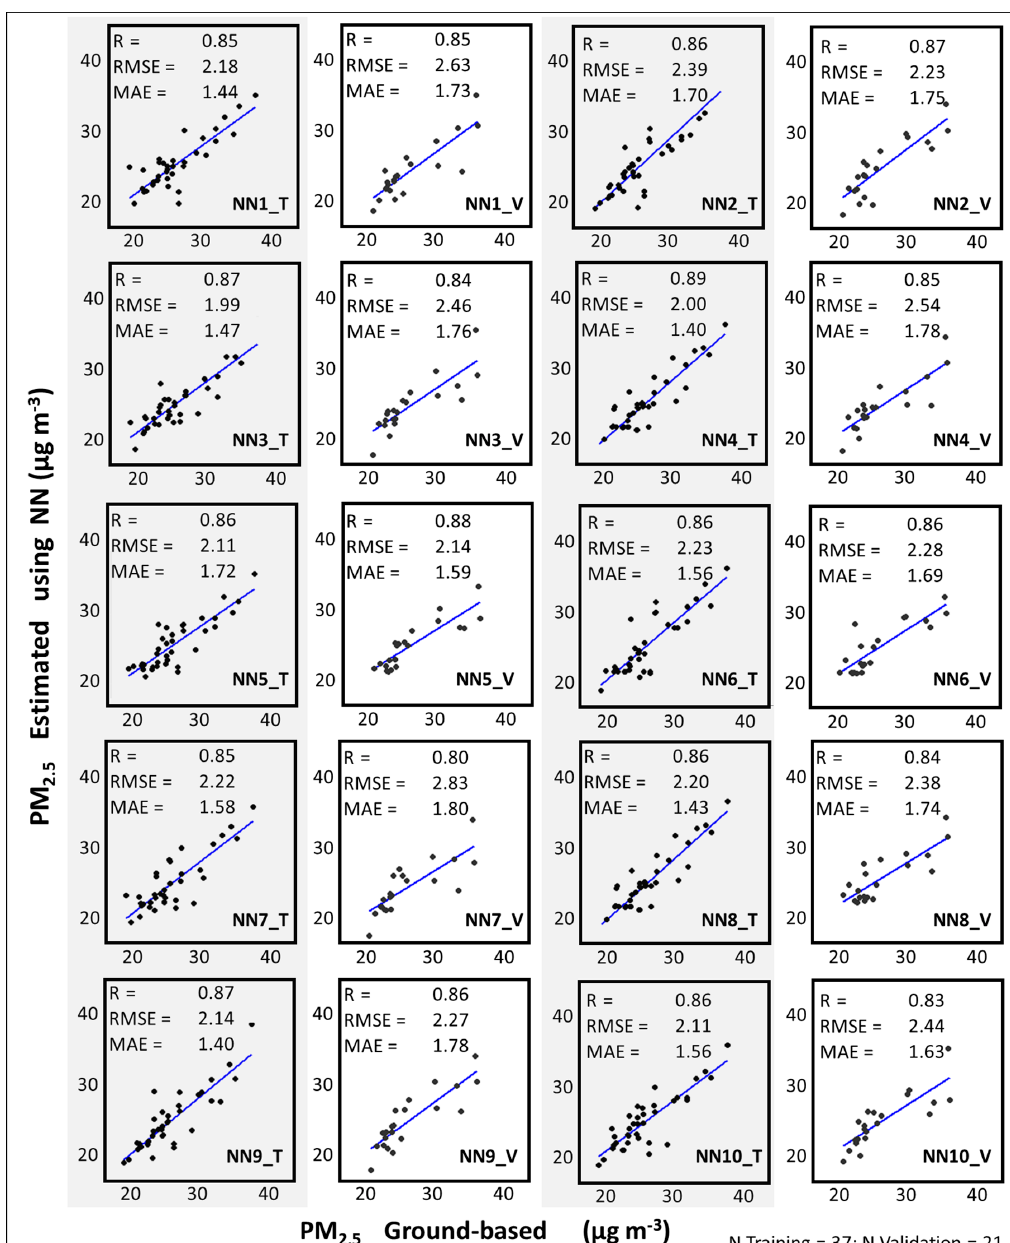
Figure 8. Statistical performance obtained from each NN used to construct the ensemble NN to estimate monthly PM 2.5 means over the MMA from January 2010–December 2014. Training (T) and validation (V) dataset .